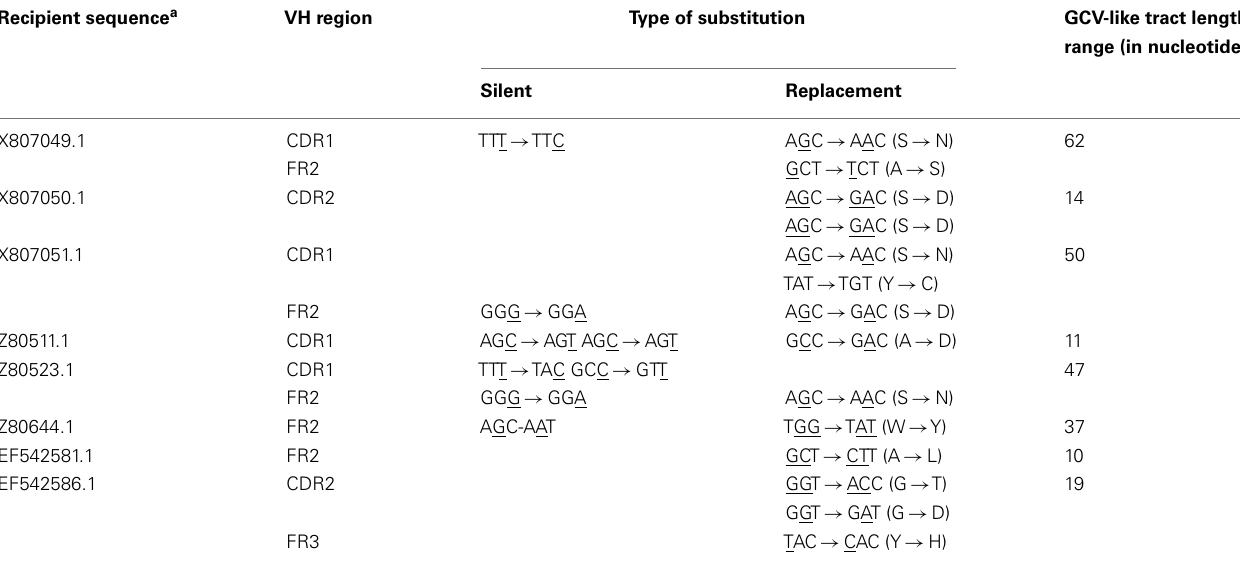
Table 5 | Characteristics of base substitutions in GCV-like tracts superimposed by SHM shown in Figures 2–4. Recipient sequence